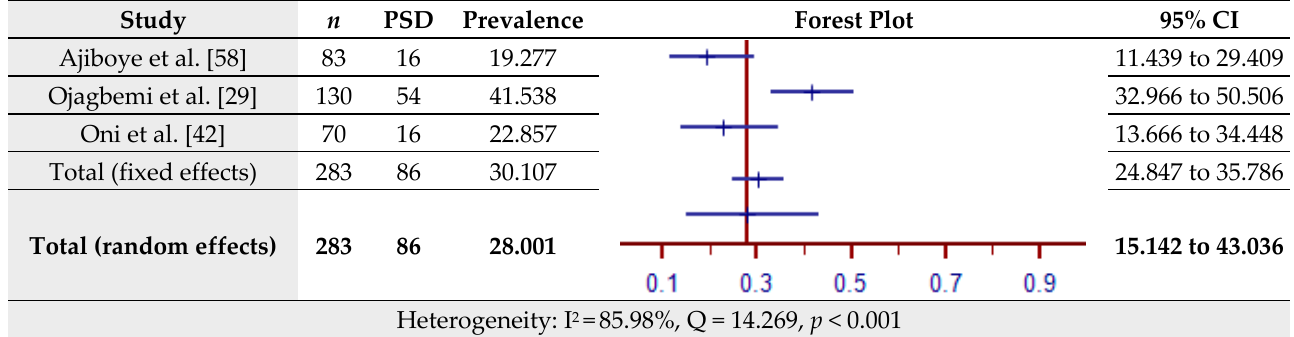
Figure 6. Prevalence estimates of Post-Stroke Depression (PSD) assessed by the Schedules for Clinical Assessment in Neu- ropsychiatry (SCAN).